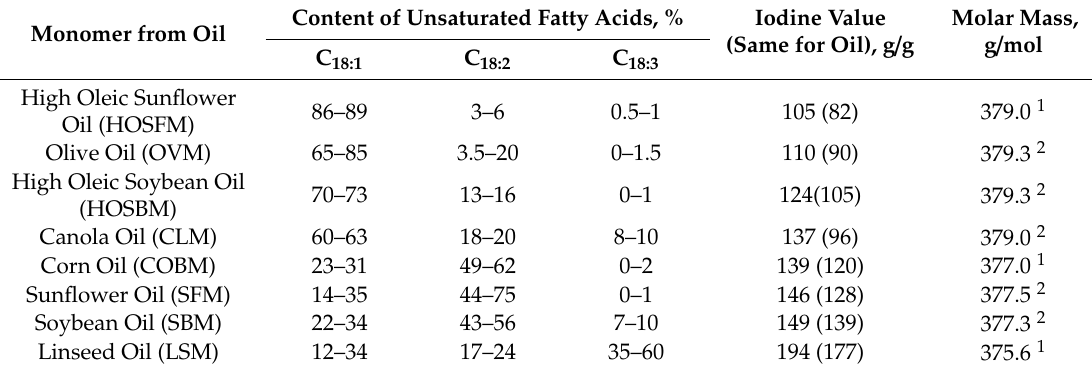
Table 2. Physico-chemical characteristics of